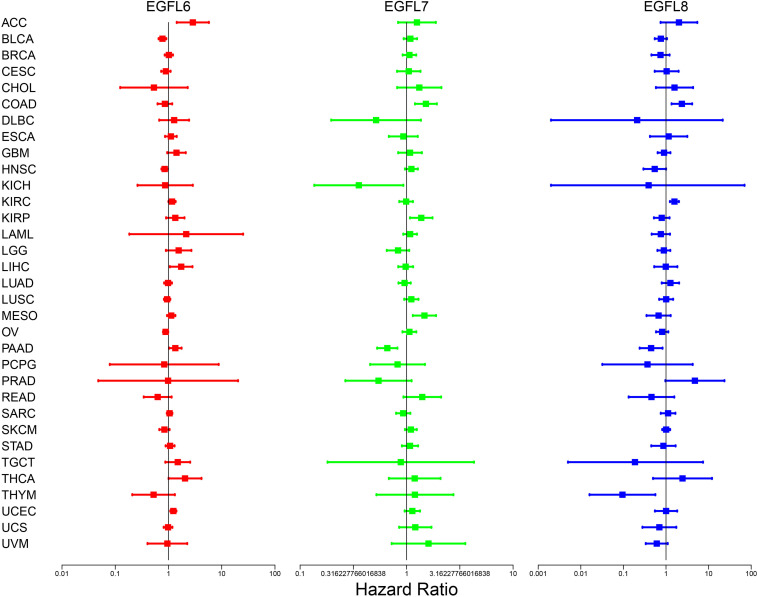
Association of EGFL6/7/8 gene expression with patient’s overall survival for different cancer types. The forest plots with the hazard ratios and 95% confidence intervals for overall survival for different cancer types showing the survival advantage and disadvantage with the increased gene expression of the EGFL6/7/8 family. The univariate Cox proportional hazard regression models were used for the association tests.